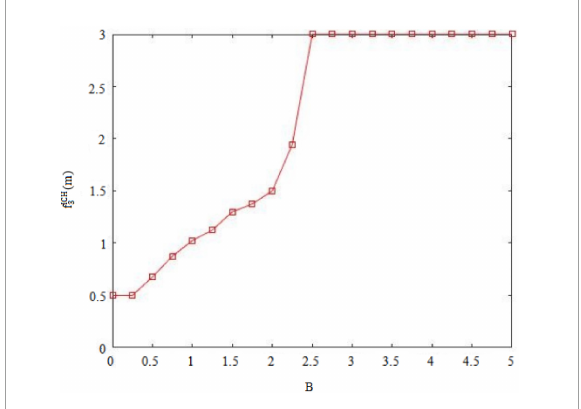
FIGURE1 Deviant innovative behaviors and perceived benefits of high risk-taking traits of “insider subordinates.”